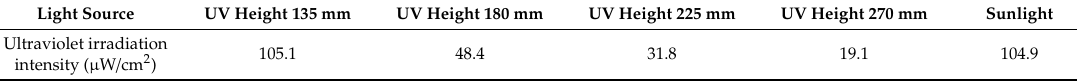
Table 3. Ultraviolet irradiation intensity of ultraviolet lamp and